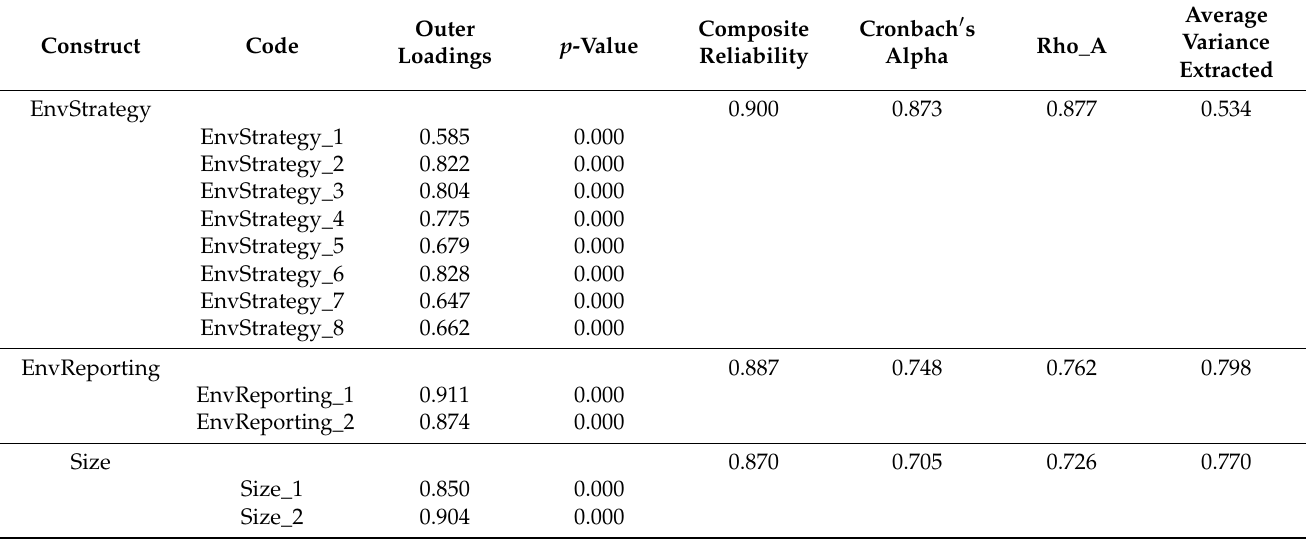
Table 2. Assessment of the measurement